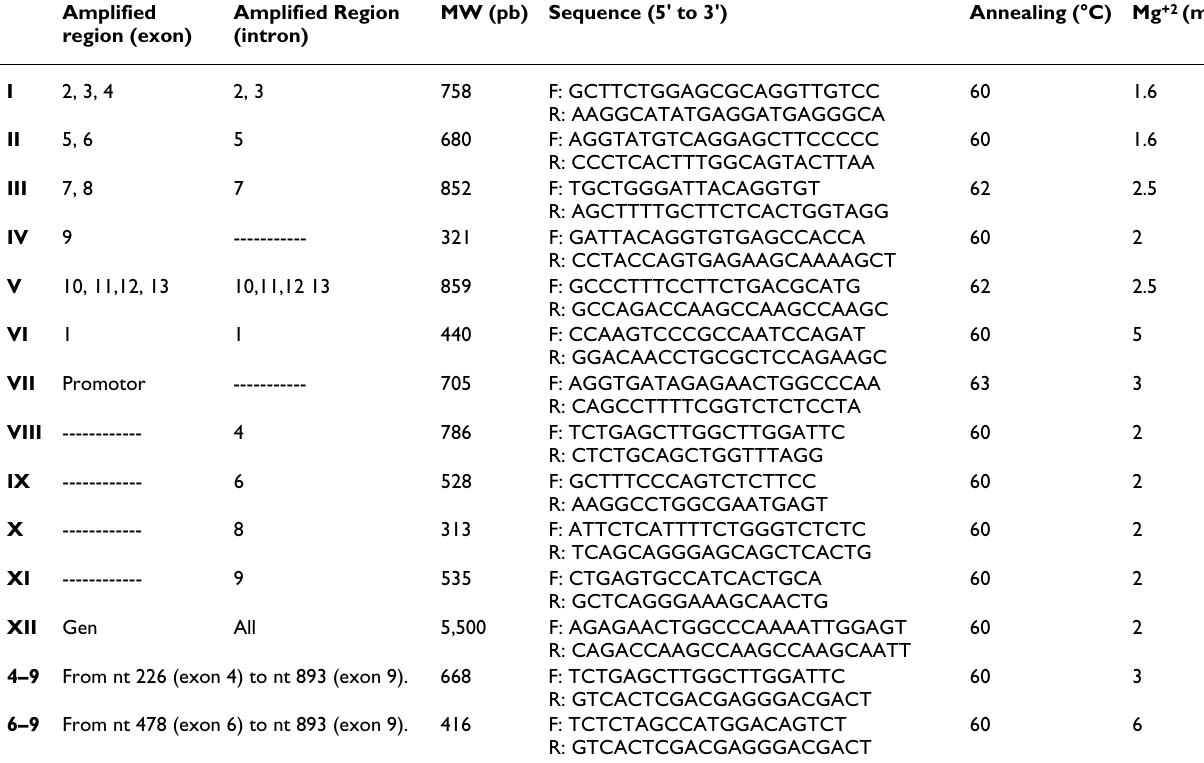
Table 2: Primers and conditions used for PPOX gene and cDNA amplification Amplified region